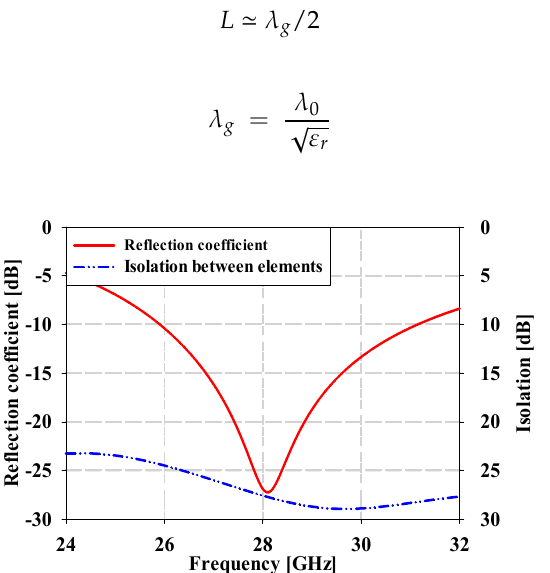
Figure 3. Simulated reflection coefficient and isolation level of the proposed two-element array.